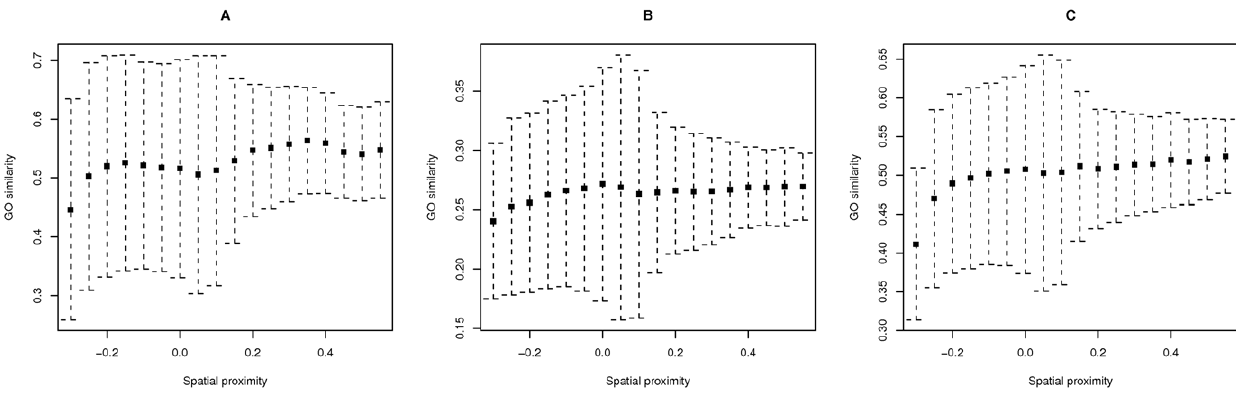
Figure 4. Correlation of the spatial proximity values with the Gene Ontology semantic similarity of the genes located in the interacting genome fragments. (A) Molecular Function. (B) Biological Process. (C) Cellular Component. Black squares show average GO similarity values, dashed lines, standard deviations.